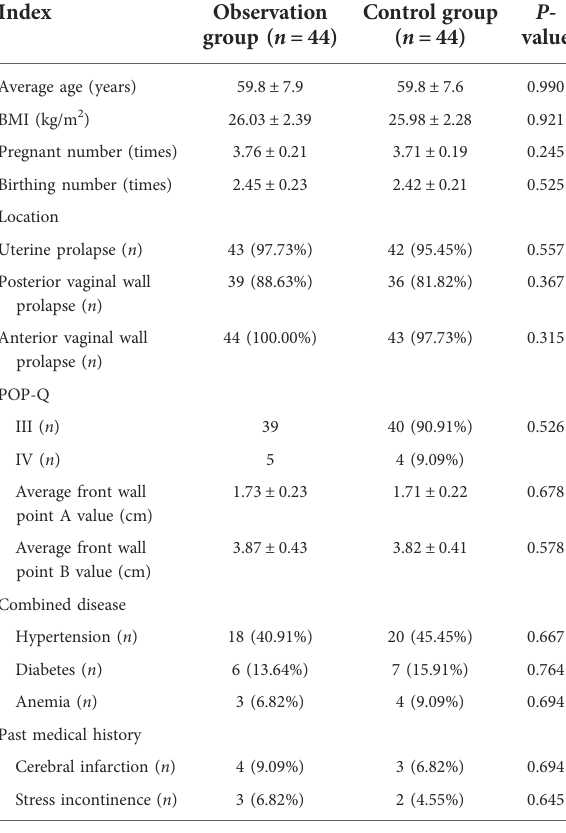
TABLE 3 Comparison of pelvic fl oor function between the two groups.